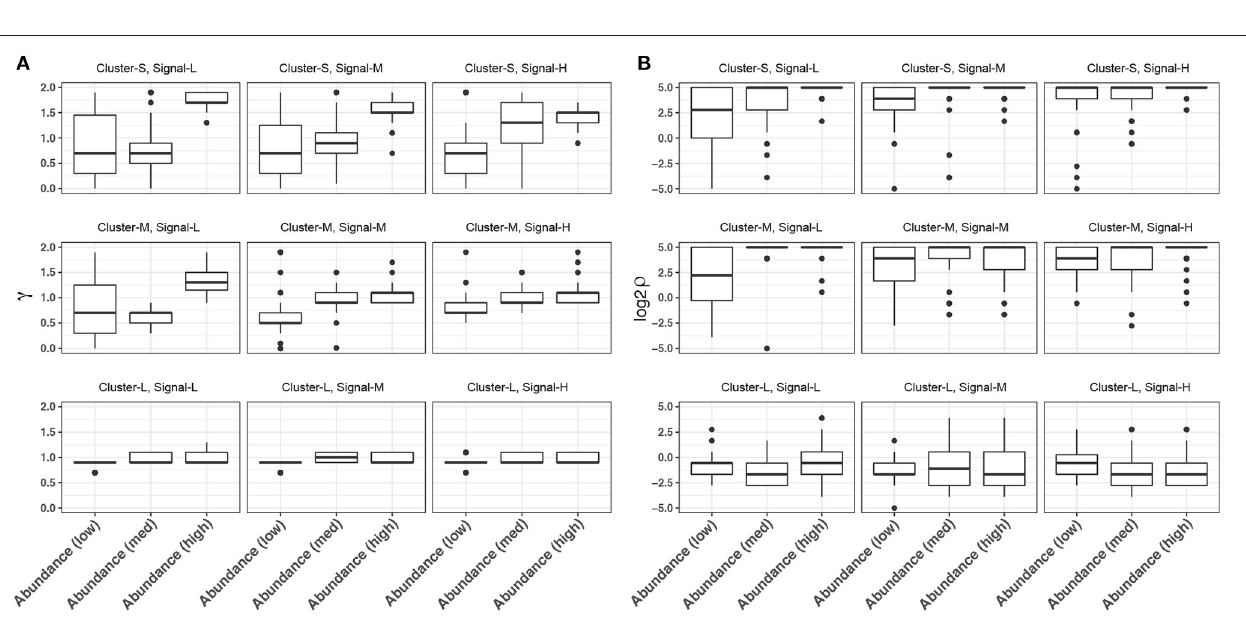
FIGURE 2 | R 2 for continuous-outcome simulations across different levels of cluster size and signal density. The abundance of associated OTU clusters is chosen to be high (A) and medium (B) . Cluster-S, -M, and -L represent small, medium and large clusters, and Signal-L, -M, and -H represent low, medium and high signal density, respectively.